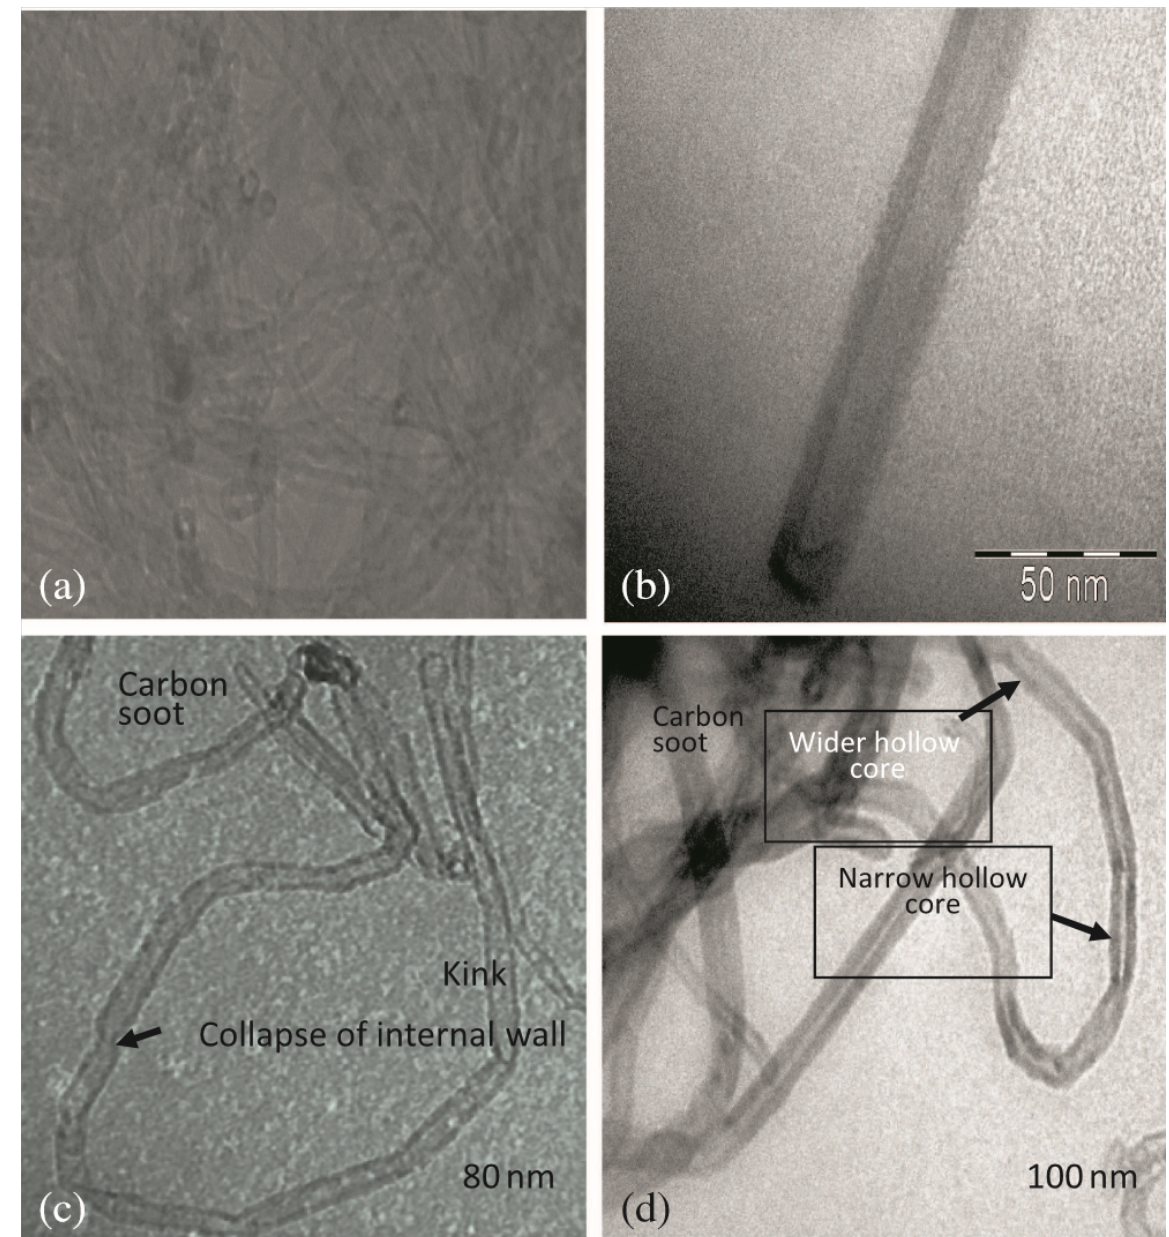
Figure 6: TEM images of MWCNTs: (a) raw, (b) 60 min heat-treated, (c) 120 min heat-treated, (d) 120 min heat-treated [ ? ]